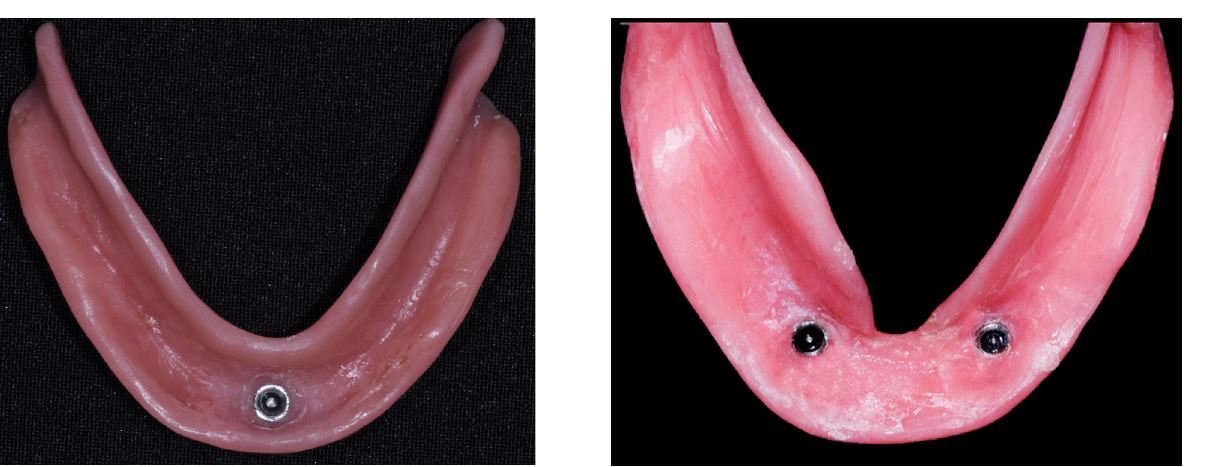
Figure 4- Mandibular overdenture supported by one implant Figure 5- Mandibular overdenture supported by two implants